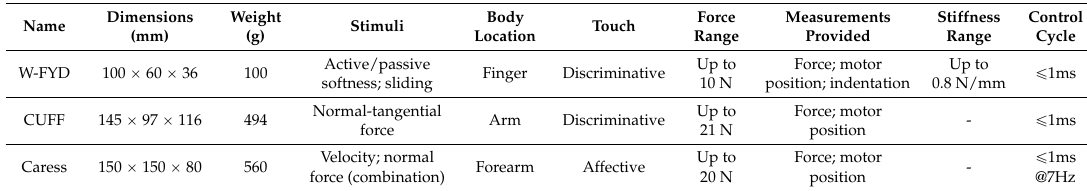
Table 3. Main characteristics of reviewed